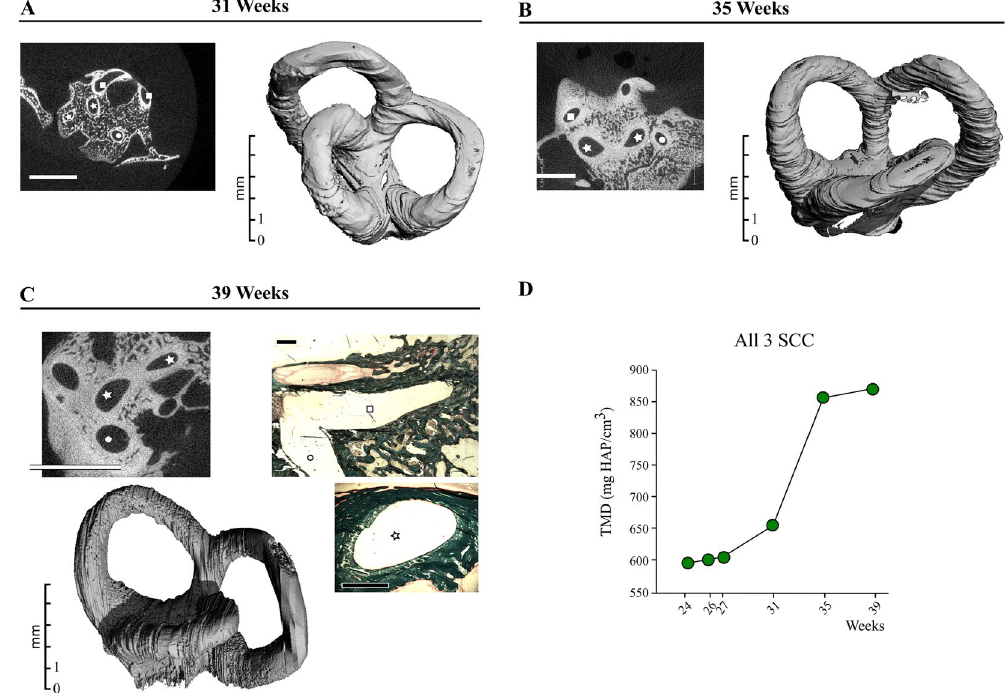
Figure 7. Maturation of the vestibular bony labyrinth. ( A – C ) 2D μ CT sections, 3D renderings and ( C ) Goldner stained sections of Semicircular Canal (SSC) labyrinth at 31 ( A ), 35 ( B ) and 39 weeks ( C ) of gestation. Stars = Lateral Semicircular Canal, squares = Superior Semicircular Canal, Dot: Posterior Semicircular Canal. White bars = 5 mm, Black bars = 1 mm. ( D ) Time-course of tissue mineral density (TMD) increase in all three SSC (ROI in Fig. 1C) at successive weeks of